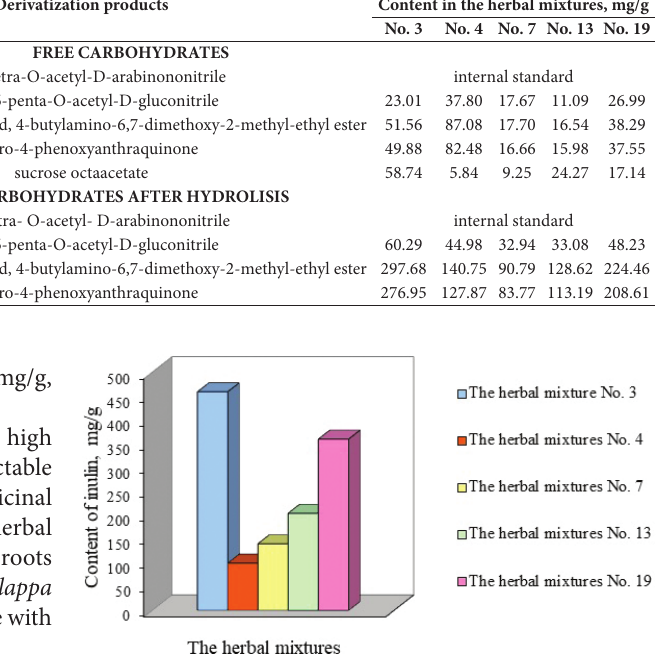
Figure 11. The diagram of the comparative analysis of inulin in the herbal